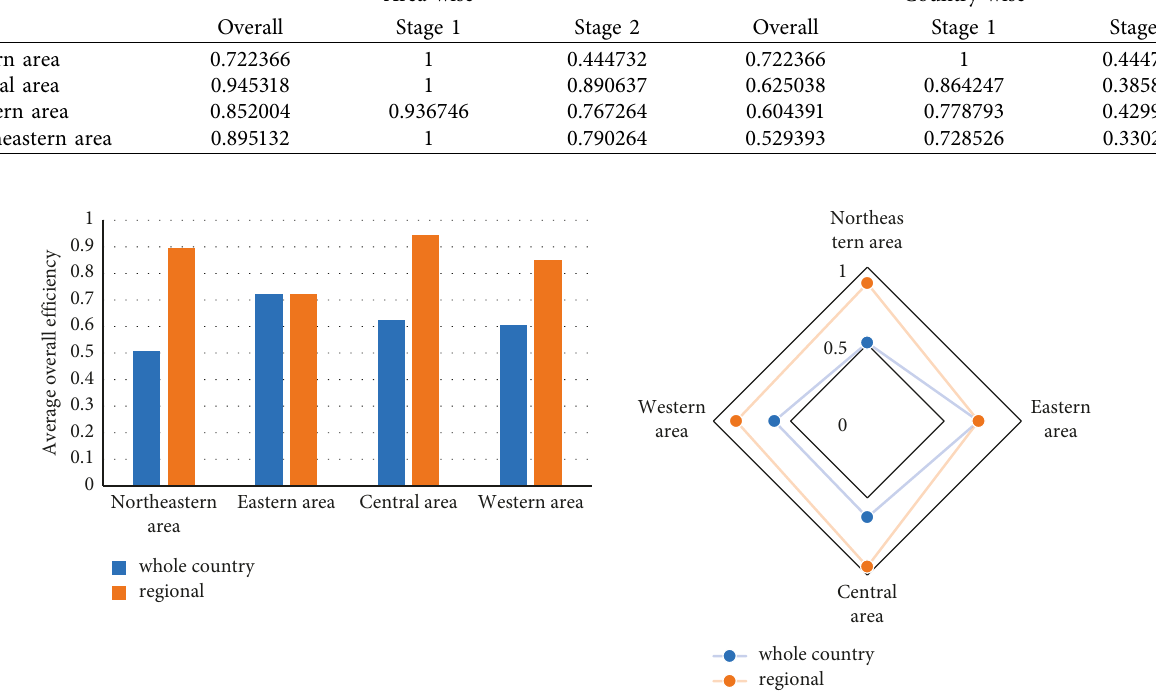
Figure 6: Comparing average overall efficiency score of